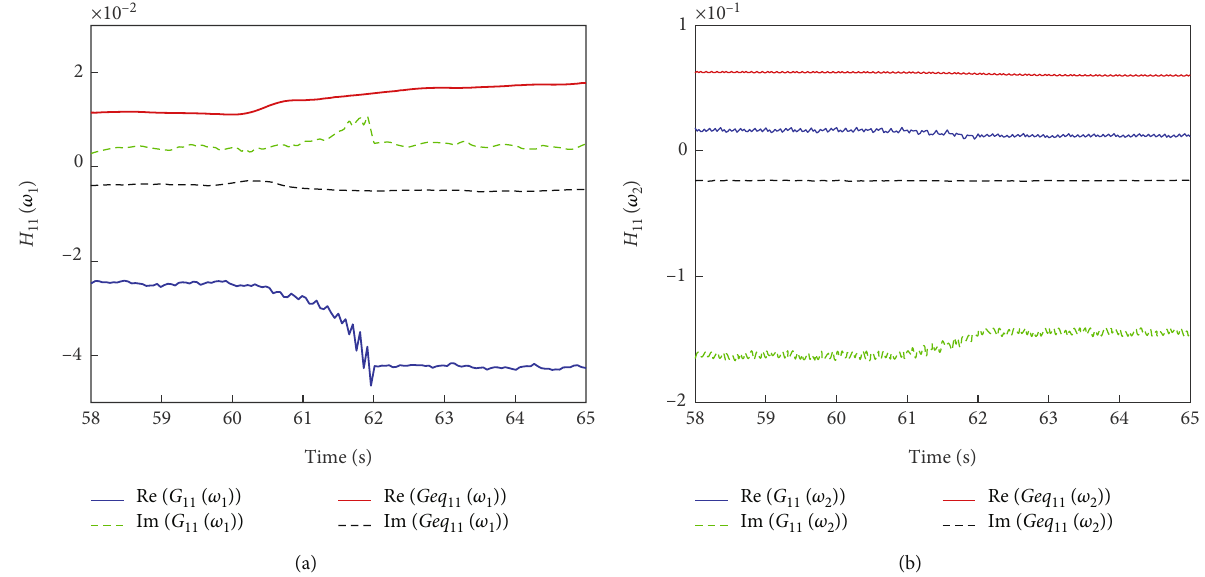
ð ω Þ and equivalent secondary path G eq 11 ð ω Þ . (b) G ð ω Þ and G eq ð ω Þ . 1 11 2 2 11 11